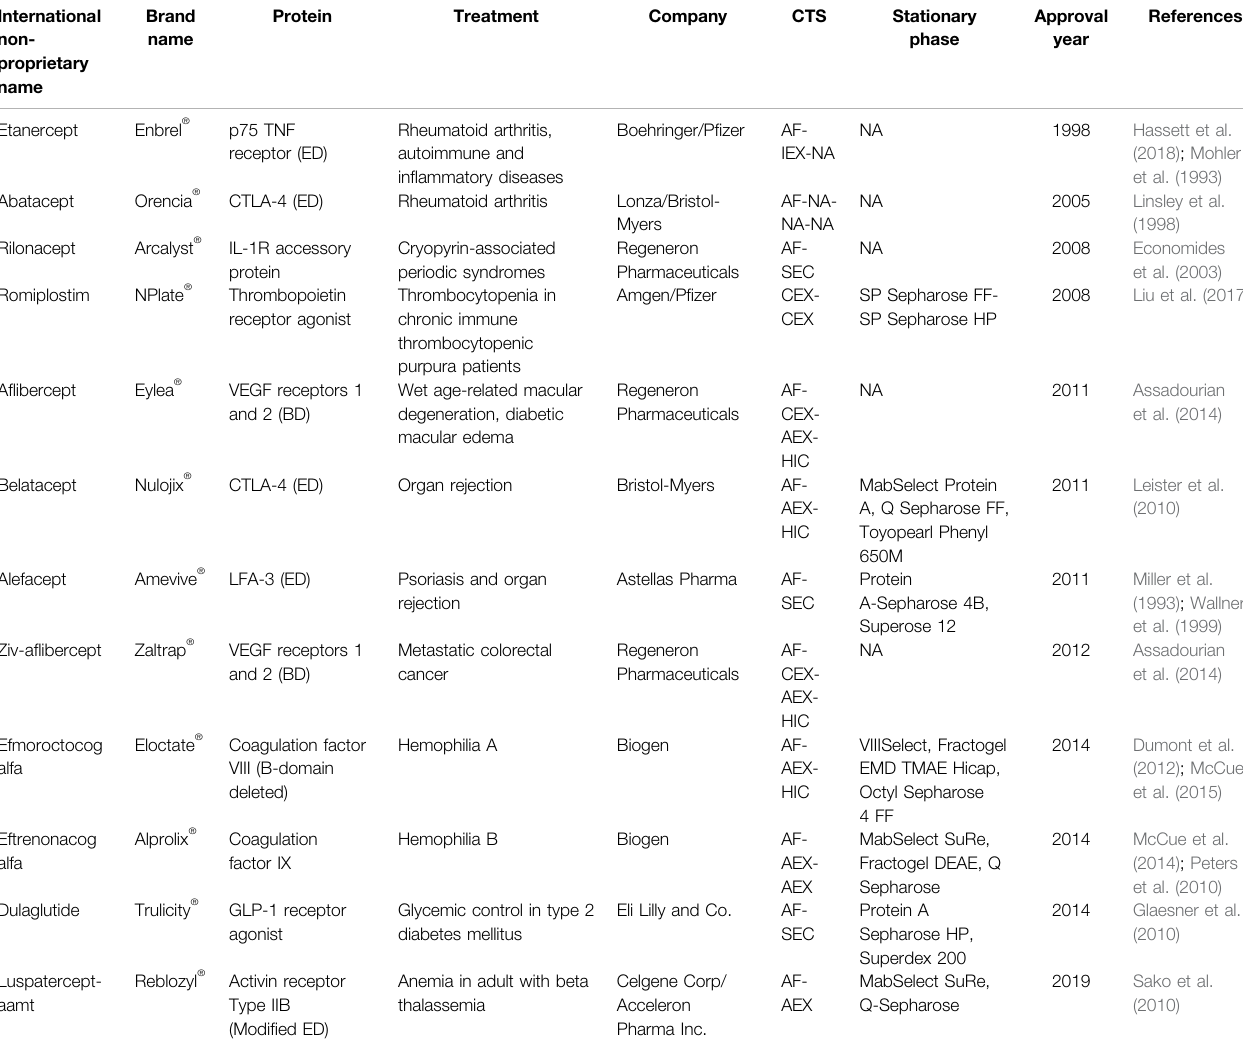
TABLE 3 | Approved Fc-fusion